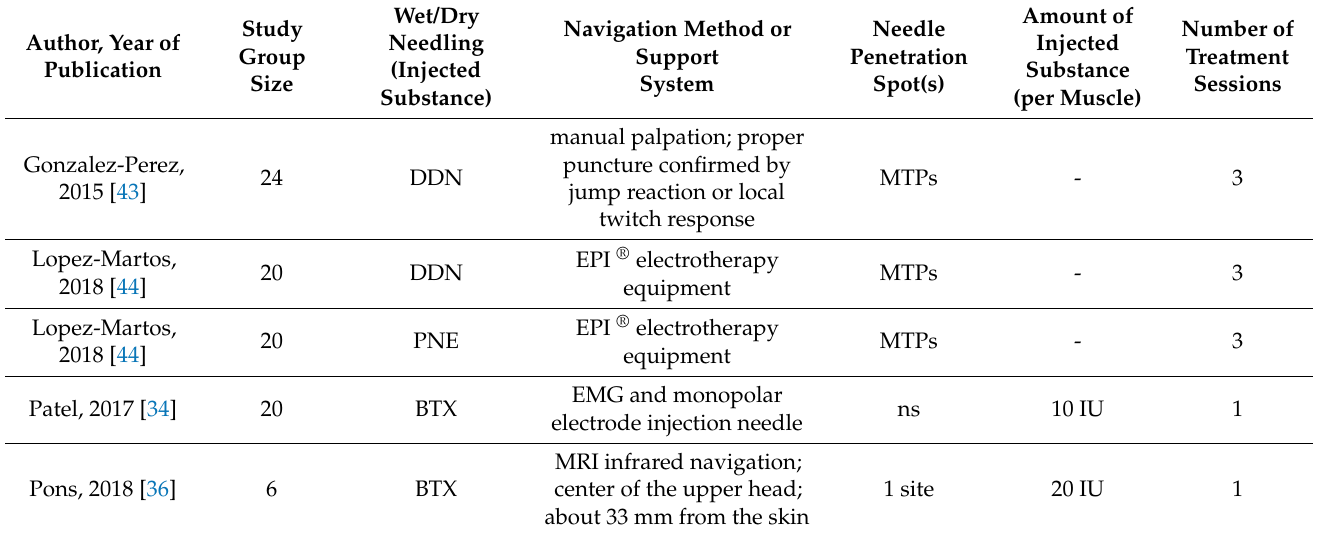
Table 5. Studies regarding lateral pterygoid muscle injections.